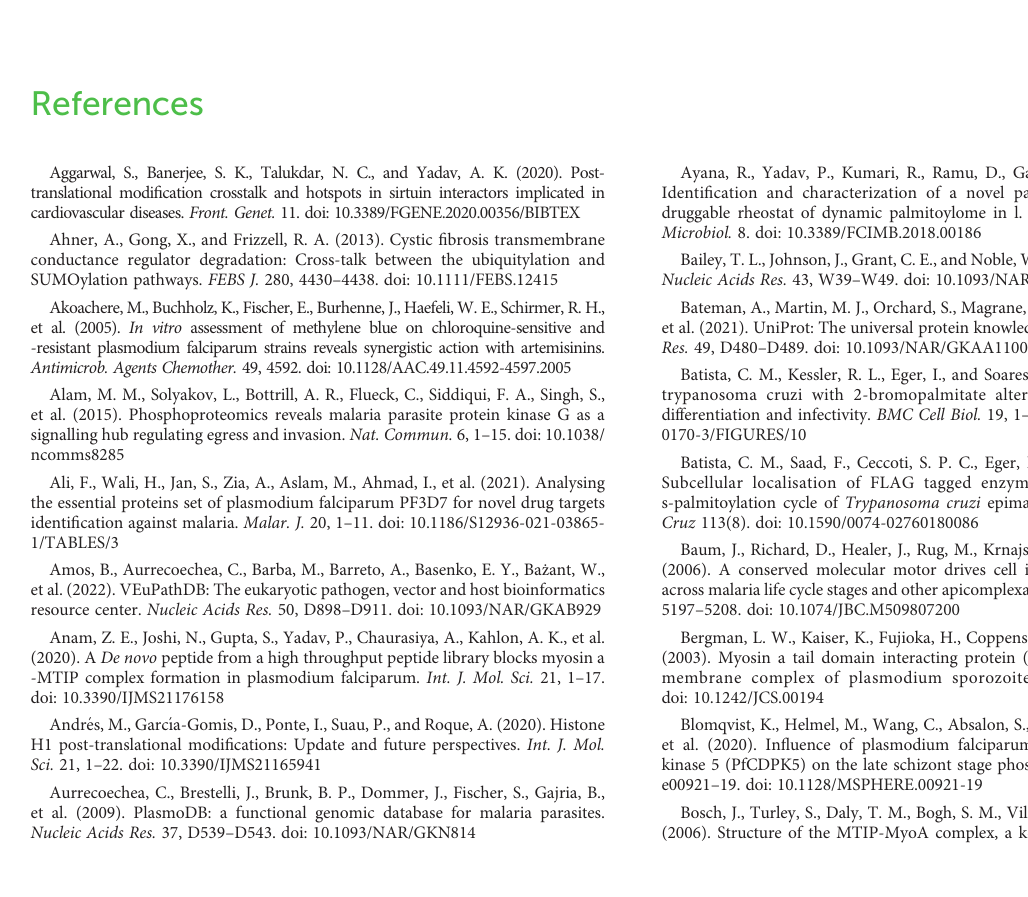
SUPPLEMENTARY TABLE 1 Total proteome of Plasmodium falciparum 3D7 cataloged for the study.